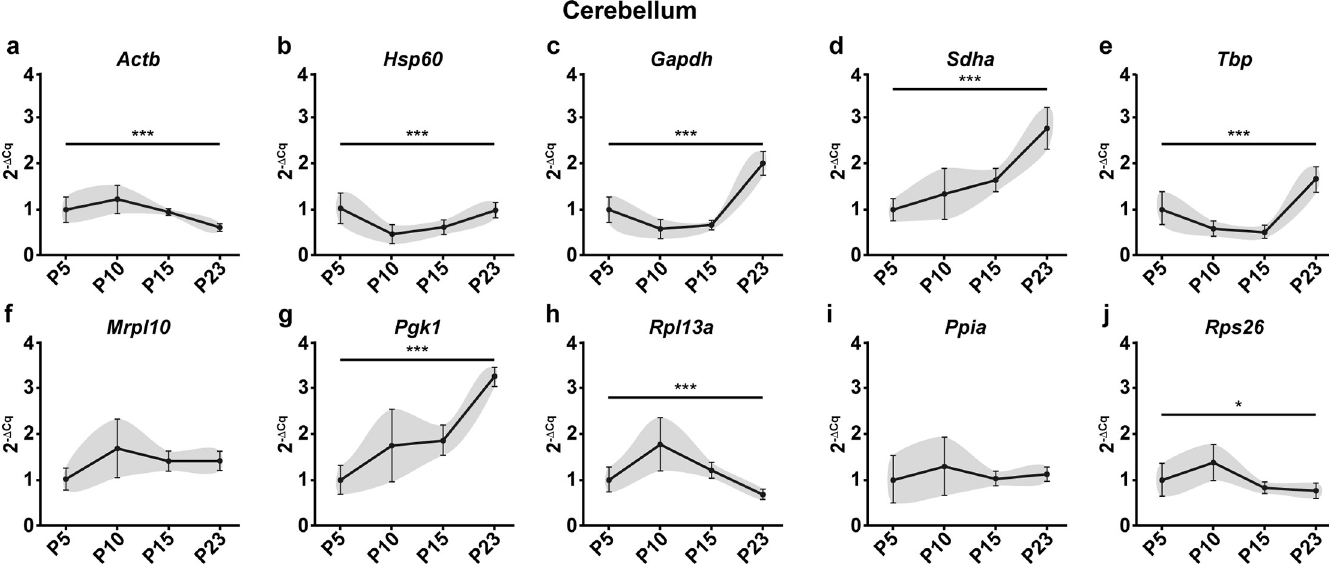
Fig 2. Raw expression profiles of reference genes expressed as fold changes across experimental groups (2 - Δ Cq ) at P5, 10, 15 and 23 in the cerebellum. P5 group is the experimental calibrator. (a) Actb, (b) Hsp60, (c) Gapdh, (d) Sdha, (e) Tbp, (f) Mrpl10, (g) Pgk1, (h) Rpl13a, (i) Ppia and (j) Rps26. Results are expressed as the Mean ± SD for each time point. One-way ANOVA was performed to assess differences between the means of all groups. Statistical significance is denoted by ‘ � ’ representing P values: � P < 0.05, �� P < 0.01, ��� P < 0.001. The grey area around each profile denotes the evolution of the intergroup and intragroup variation across time